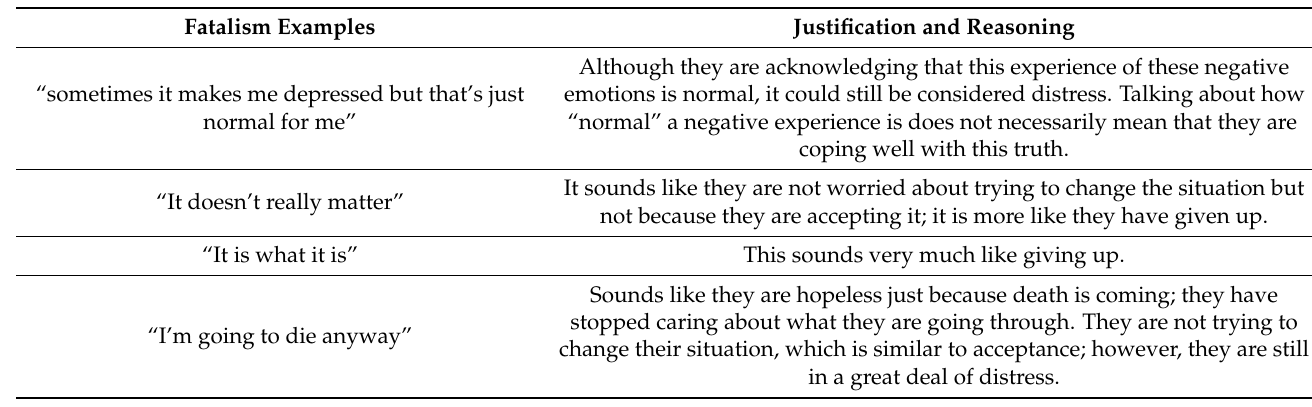
Table A2. Fatalism Examples. Examples of fatalism-related quotes identified prior to analysis with author’s corresponding justification and reasoning as to why these quotes indicated